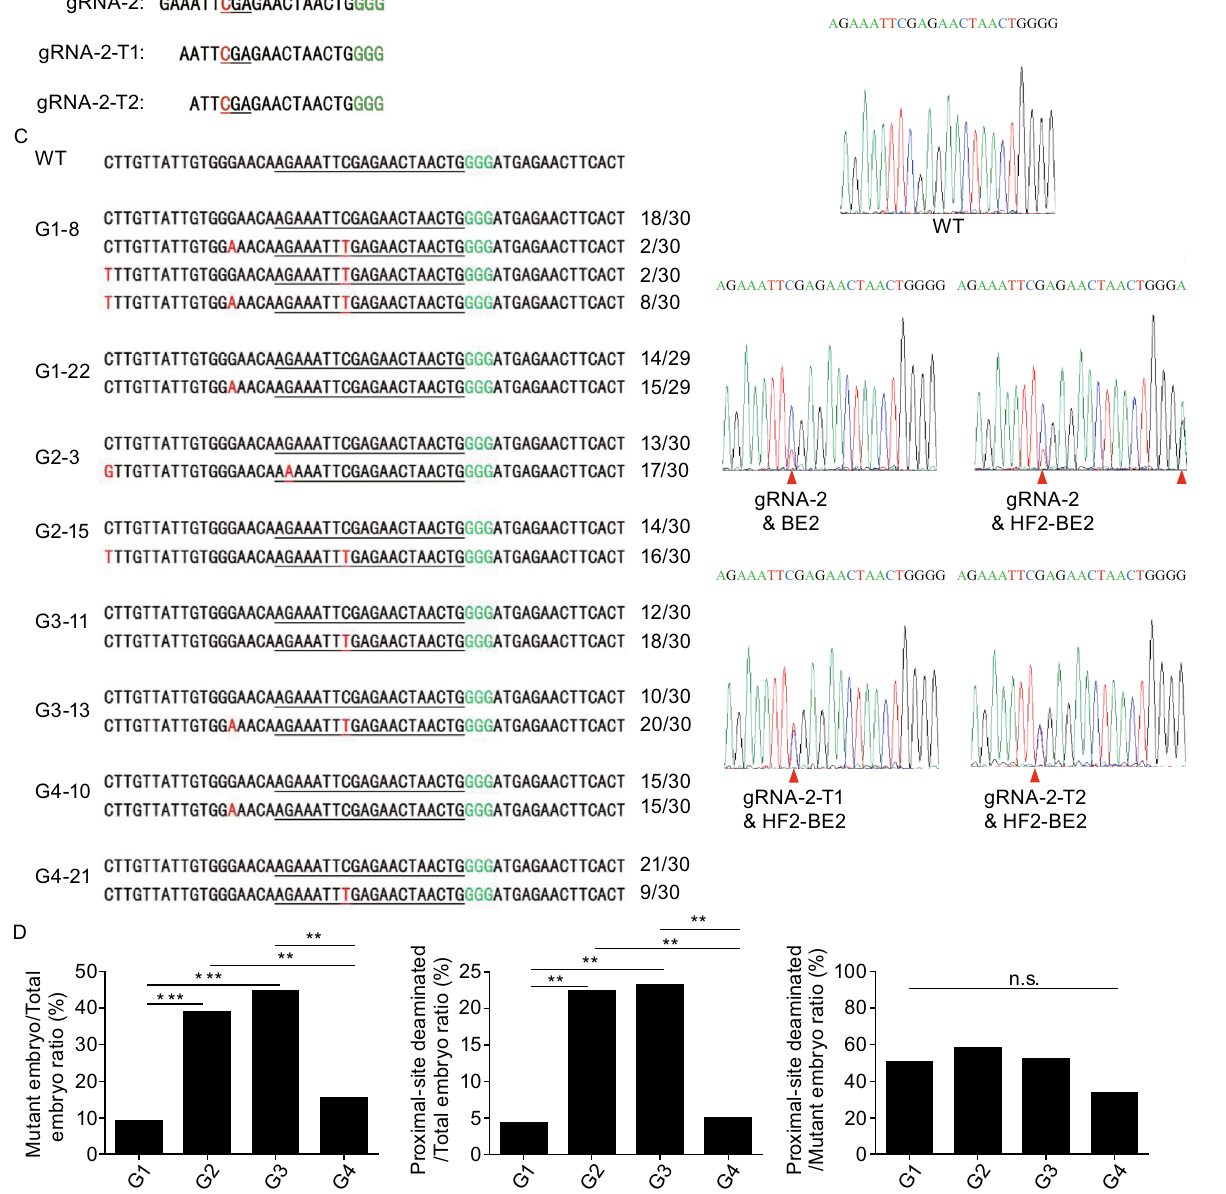
Figure 4. Examination of proximal-site deamination by HF2-BE2. (A) Design of truncated gRNA variants of gRNA-2 (gRNA-2-T1 and gRNA-2-T2). The codon to be modi fi ed is underlined, with the nucleotide to be deaminated in red. PAM is in green. (B) Representative sequencing chromatographs of the PCR amplicons of target sites from the embryos are shown here. Bases successfully edited are indicated by red arrowheads. (C) PCR amplicons of target sites from embryos were subcloned into pGEM-T vectors and sequenced. The number of clones for each sequence pattern is indicated. Underlined, gRNA target regions. Green, PAM sequence. Red, point mutations. (D) Statistical analysis of base editing by HF2-BE2 and BE2 in mouse embryos. n.s., not signi fi cant, P values > 0.05. ** P < 0.01, *** P < 0.001, statistical signi fi cance was determined using the χ 2